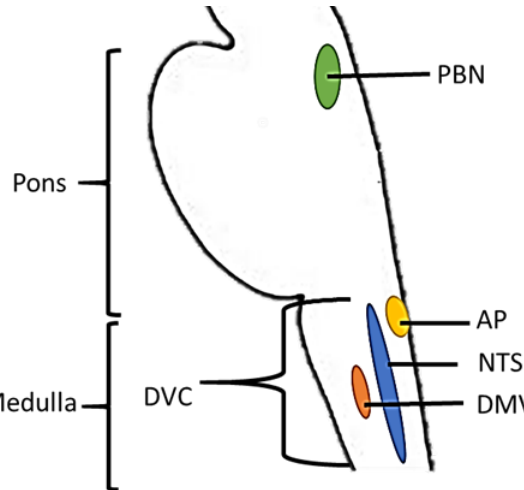
Figure 3. Graphical representation of a sagittal section of the brainstem. Depicted areas are involved in processing taste- and gastric signals and energy-related peripheral signals (hormones and metabolites). AP = Area postrema, DVC = dorsal vagal complex, DMV = Dorsal motor vagus, NTS = nucleus of the solitary tract, PBN = Parabrachial nuclei. Locations of brain areas are based on Duvernoy’s Atlas of the human brain stem [62].